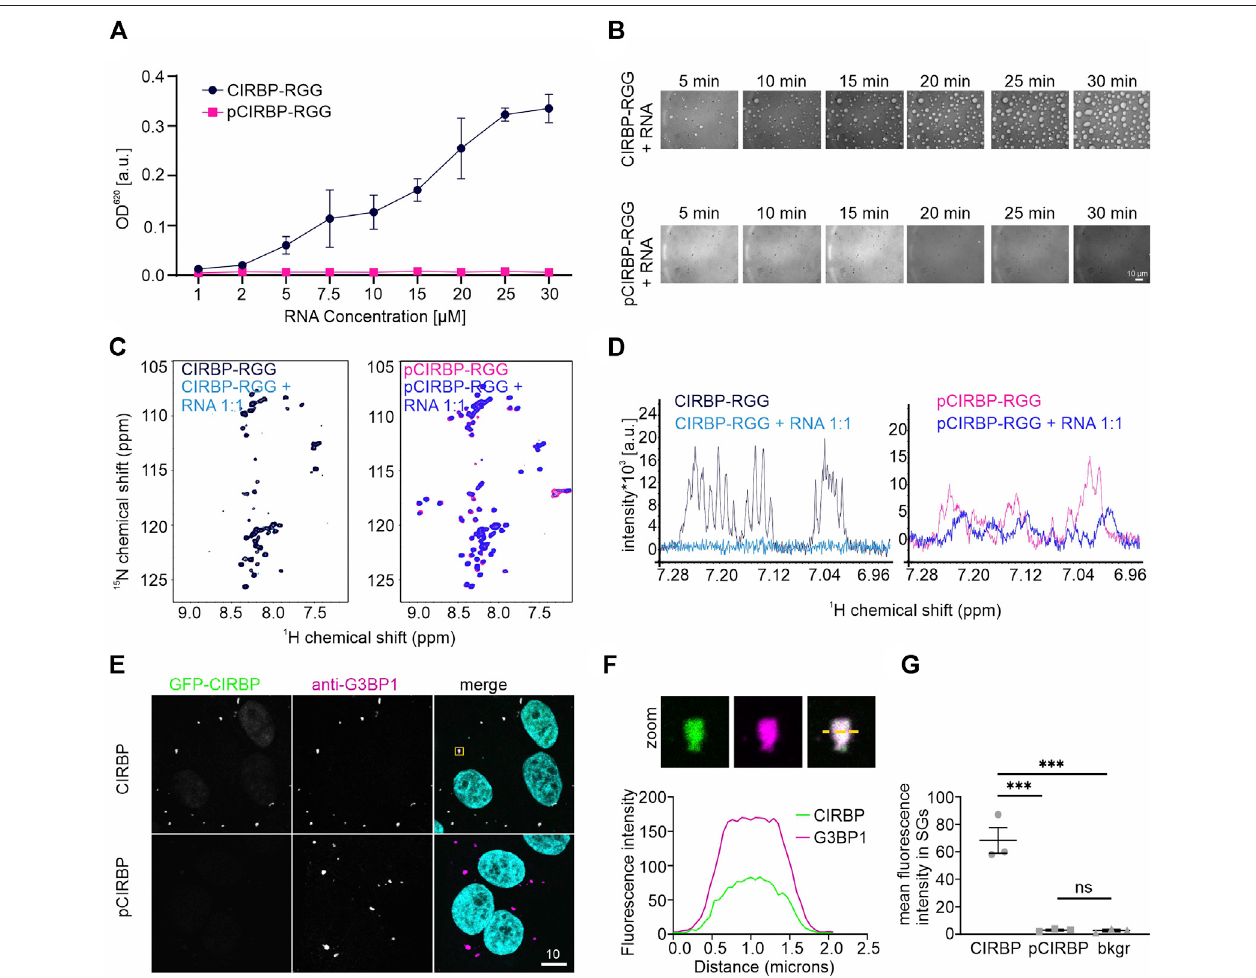
FIGURE 2 | SRPK1-mediated phosphorylation of CIRBP-RGG impairs its phase separation and SGs recruitment. (A) Turbidity assay performed at a fi xed concentration of CIRBP-RGG and pCIRBP-RGG (both at 30 µM) with an increasing concentration of (UG) 12 RNA. (B) Differential interference contrast microscopy images illustrating CIRBP-RGG (upper panel) and pCIRBP-RGG (bottom panel) at a concentration 30 µM in the presence of 15 µM (UG) 12 RNA. Images were recorded over 30 min, scale bar is 10 µm. (C) 1 H- 15 N HSQC spectra of 50 µM 15 N-labeled CIRBP-RGG (left panel, in black) and 50 µM 15 N-labeled pCIRBP- RGG (right panel, in magenta) in the absence and presence of 50 µM (UG) 12 RNA (in blue and dark-blue for CIRBP-RGG and pCIRBP-RGG, respectively). (D) 1 H-NMR spectra of 50 µM 15 N-labeled CIRBP-RGG (left panel, in black) and 50 µM 15 N-labeled pCIRBP-RGG (right panel, in magenta) in the absence and presence of (UG) 12 RNA at a 1:1 stoichiometric ratio (in blue and dark-blue for CIRBP-RGG and pCIRBP-RGG samples, respectively). The spectra were recorded immediately before the corresponding 1 H- 15 N HSQC spectra in Figure 2C . (E) Association of CIRBP-EGFP (upper panel) and phosphorylated CIRBP-EGFP (lower panel) withSGsinsemi-permeabilizedHeLacells.Scalebar:10 μ m.Yellowboxindicatesthezoomed-inimagesshownin Figure2F . (F) Unmodi fi edCIRBPcompletely enters the SG as shown by a zoomed-in image of an exemplary SG and plot pro fi les of fl uorescence intensities for G3BP1 and GFP-CIRBP along the yellow line. (G) Quanti fi cationofthemean fl uorescenceintensityofCIRBP-EGFPandphosphorylatedCIRBP-EGFPinSGsforthreeindependentreplicateswith ≥ 44SGs ± SEM.*** p < 0.0002 by an one-way ANOVA with Tukey ’ s multiple comparison